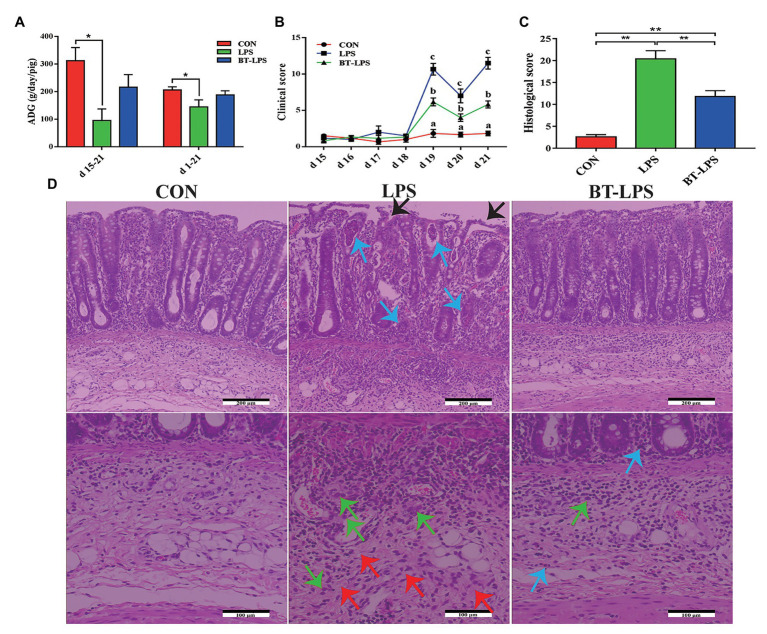
Dietary supplementation with butyrate improved clinical scores and protected colonic morphology of weaned piglets caused by lipopolysaccharide (LPS). (A) Average daily gain (ADG) of piglets. (B) Clinical scores of piglets based on an evaluation system of 0–15 scores. (C) Colonic histological scores on day 21 based on an evaluation system of 0–30 scores. (D) Representative colon histological sections of LPS-challenged and butyrate-treated piglets. Arrows in the sections indicate major histopathological differences between treatments: epithelial damage (black arrow), granulocyte inflammation (blue arrow), monocyte inflammation (green arrow), and submucosa edema (red arrow). All values are expressed as the mean ± SEM (n = 6). *p < 0.05 and **p < 0.01. a–c in the figure are used to mark the significant differences among treatments, indicating p < 0.05.